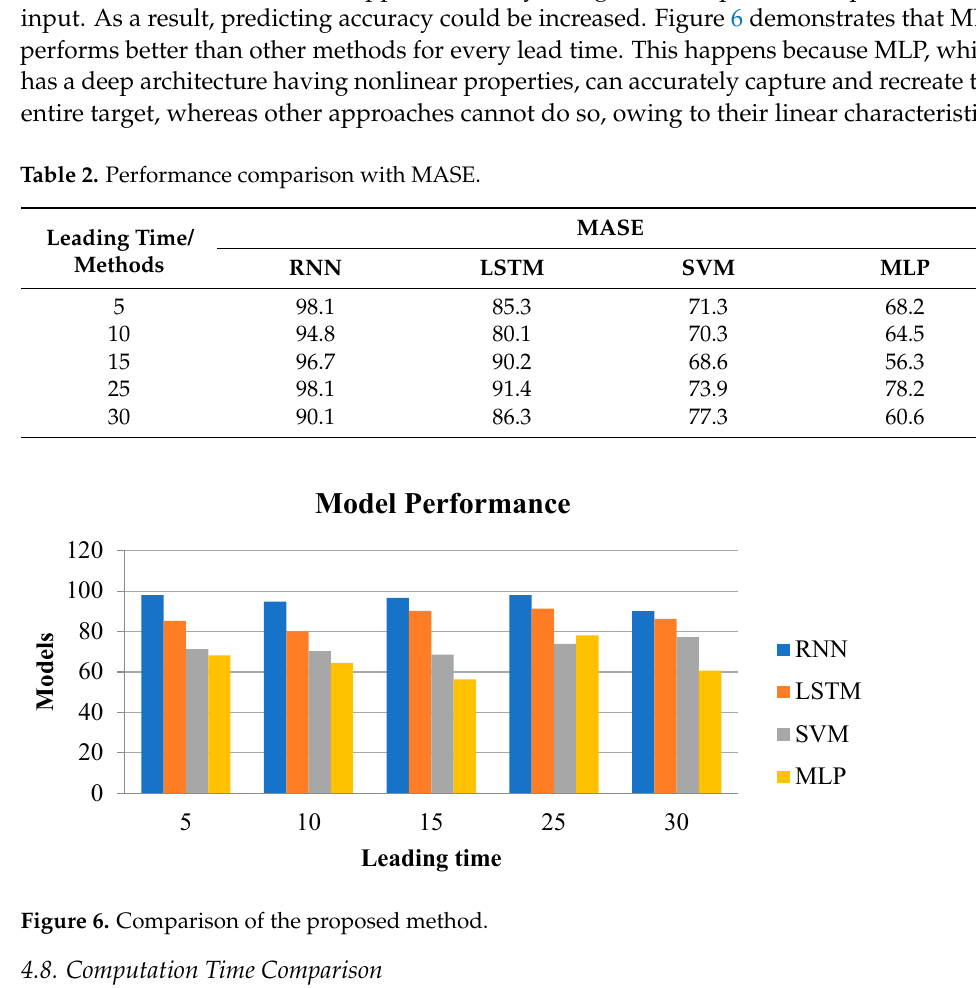
Table 3. Time computation comparison. Leading Method/Methods